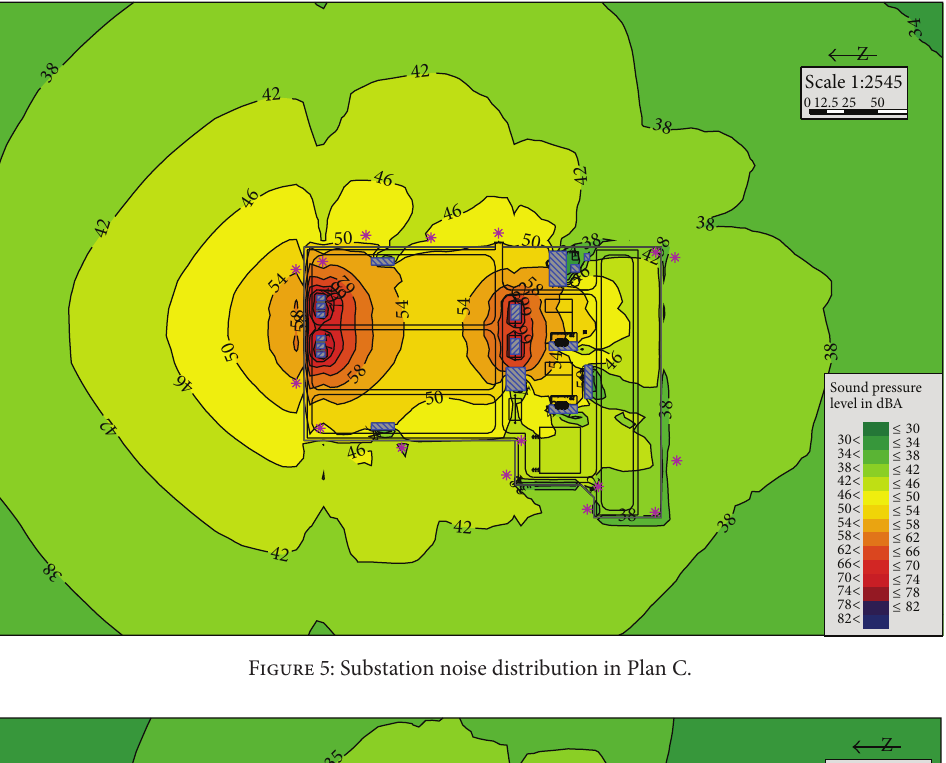
Figure 5: Substation noise distribution in Plan C.